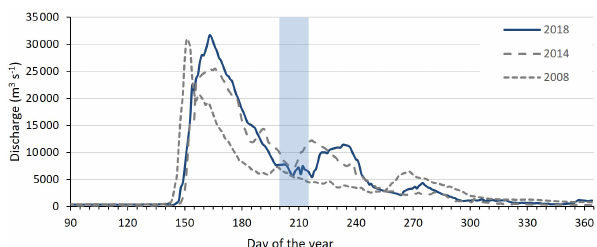
Figure A1. Discharge of the Kolyma River at Kolymskoye, about 40km upriver of sampling point K 1, in 2018 (Shiklomanov et al., 2021, Artic GRO dataset). Sampling period of this study highlighted in blue, directly after spring freshet. In grey dotted lines the dis- charge of the Kolyma River during the 2008 and 2014 East Siberian Sea sampling campaigns for